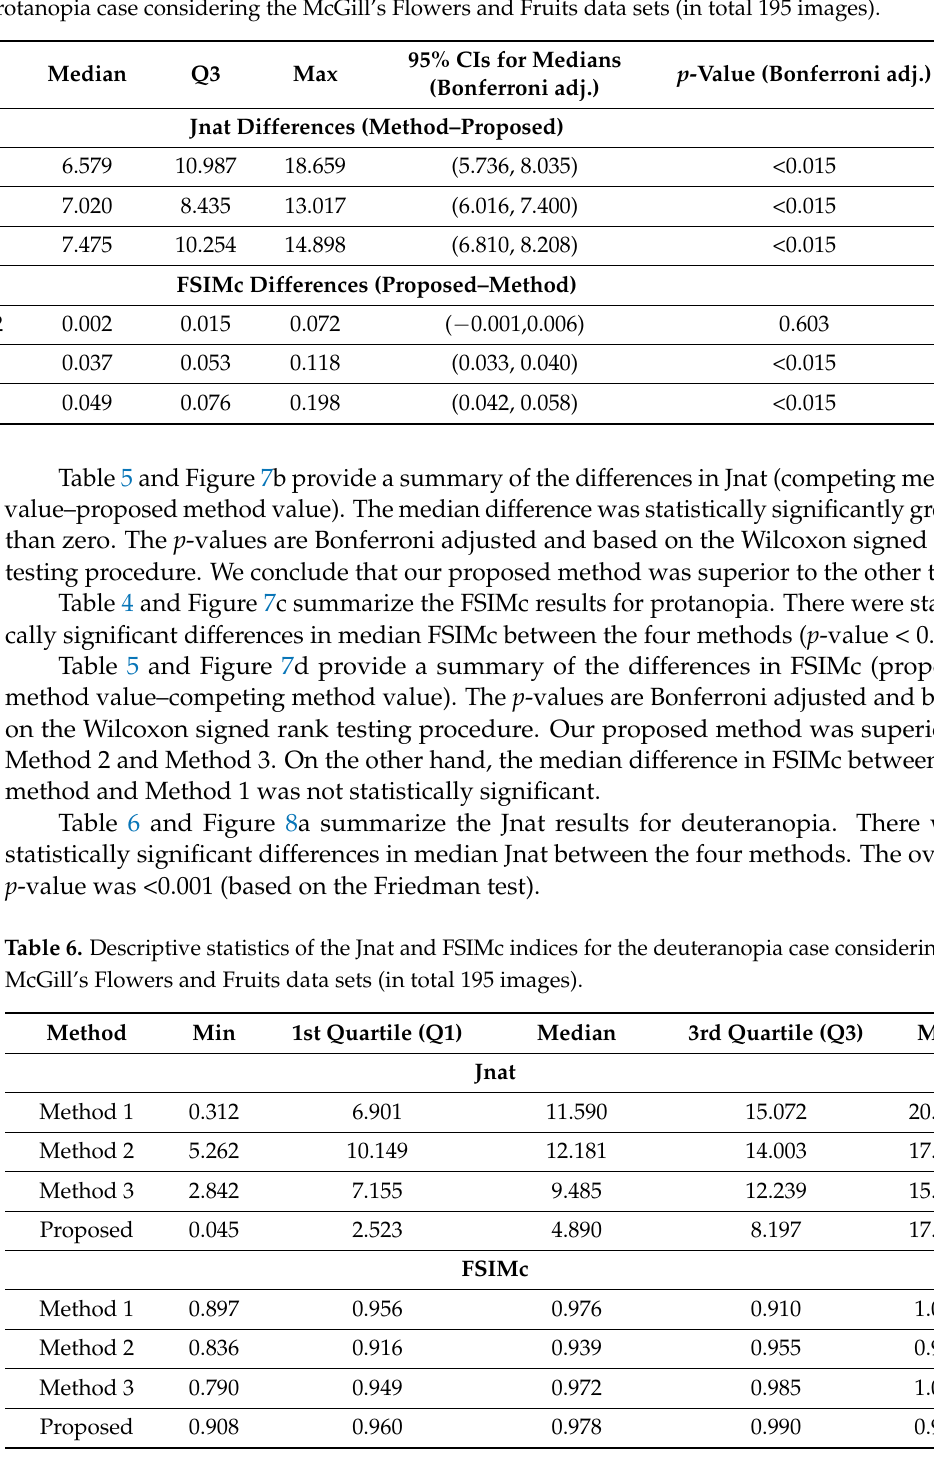
Table 5. Descriptive statistics of the observed Jnat and FSIMc differences between the three competing methods and the proposed method for the protanopia case considering the McGill’s Flowers and Fruits data sets (in total 195 images).